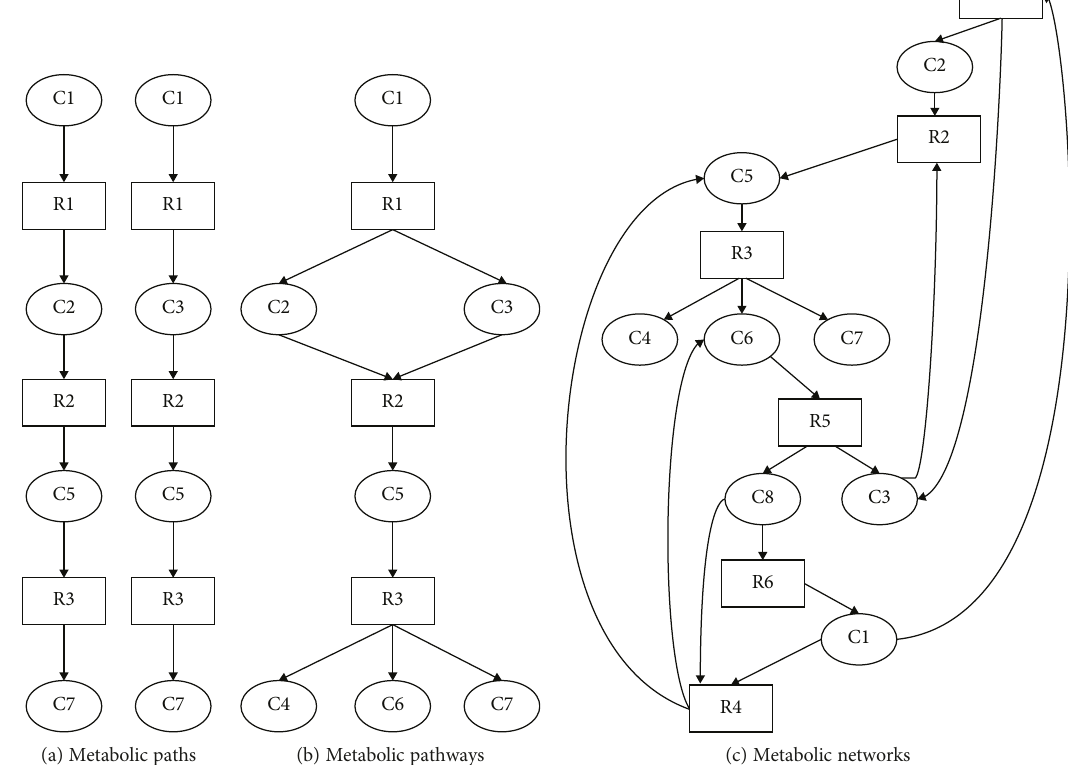
Figure 1: (a) describes the paths in a metabolic network construction; (b) describes the pathways; and (c) describes the entire networks of the metabolic